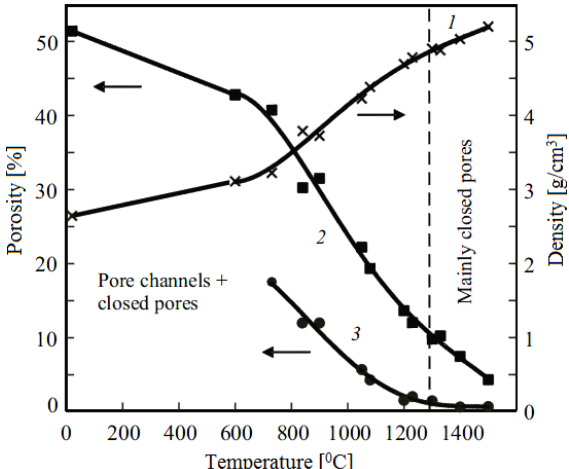
Figure 38. Density ( 1 ) and porosity ( 2 and 3 ) of TiN sintered at different temperatures: 2—total porosity and 3—pores to 300